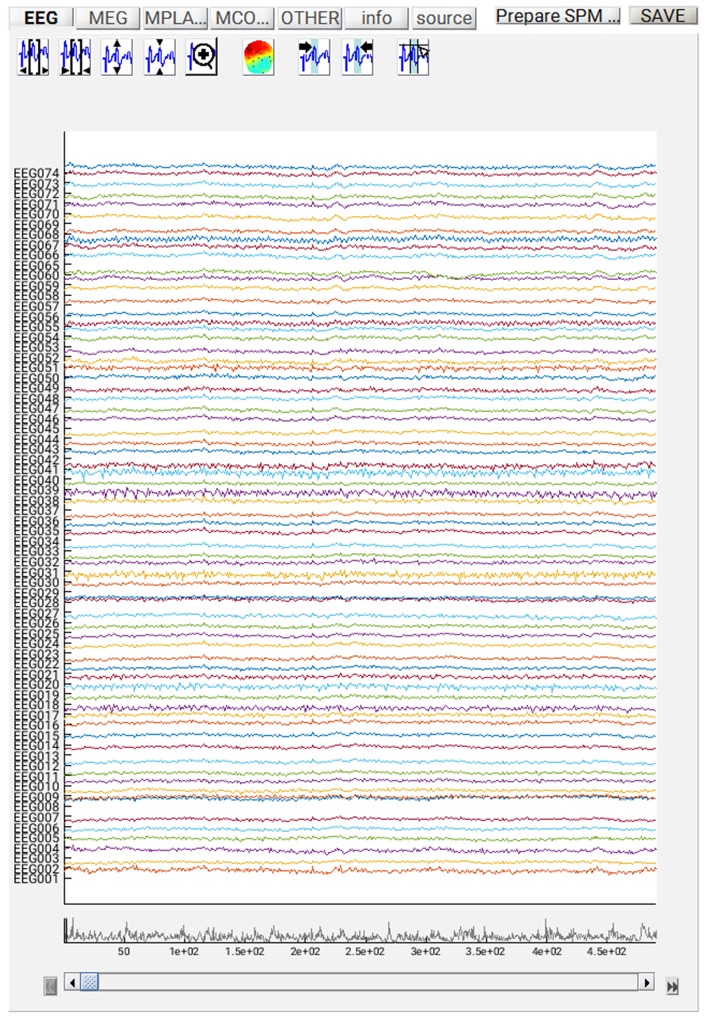
Continuous EEG recordings in SPM graphics window.